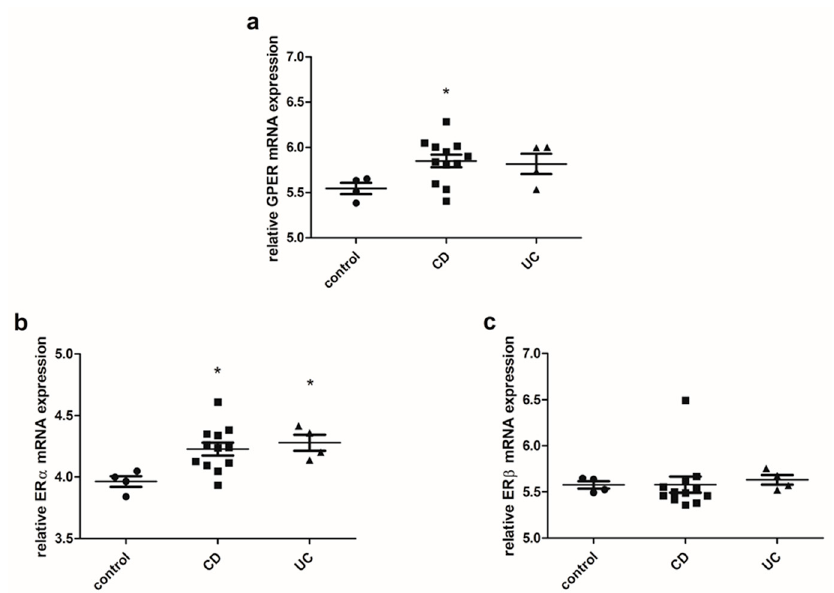
Figure 3. Expression of GPER ( a ), ER α ( b ) and ER β ( c ) at the mRNA level in CD and UC patients and the control group regardless of sex and age (control, n = 4; CD, n = 12; UC, n = 4). Values are means ± SEM; * P < 0.05 vs. control.